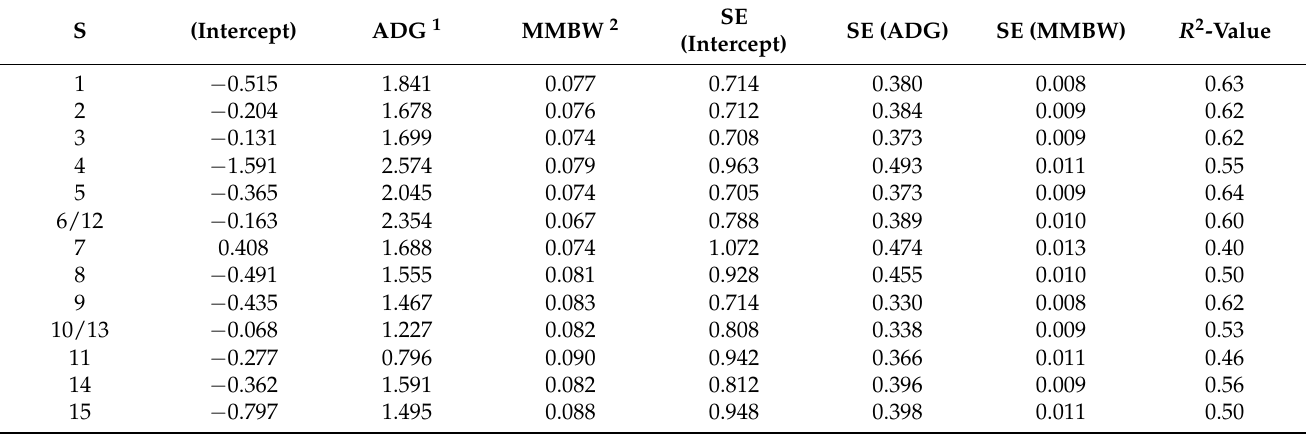
Table 7. Regression coefficients, their standard errors (SE), and the R 2 value for different measurement standards (S1–15, see Table 3 for the details of the standards) based on the data from experiment 3.